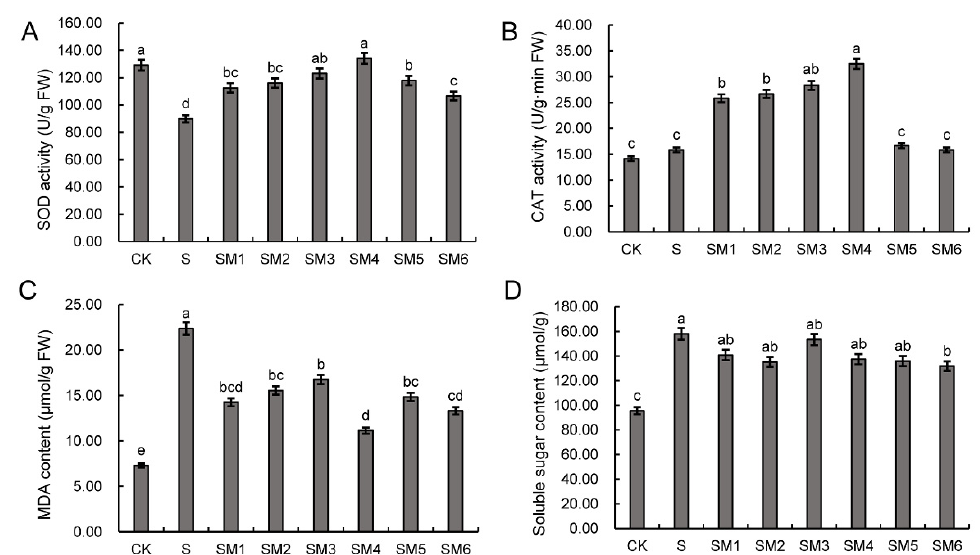
Figure 1. Changes in physiology in wheat seedlings under water control (CK), salt stress (S), and salt stress with different MT concentrations (SM) treatment conditions. ( A – D ) Changes in the SOD activates ( A ), CAT activities ( B ), MDA contents ( C ), and soluble sugar contents ( D ). The error bar in the figure represents the standard deviation (SD, n = 3). Different letters indicate significant differences by the Duncan test ( p < 0.05).